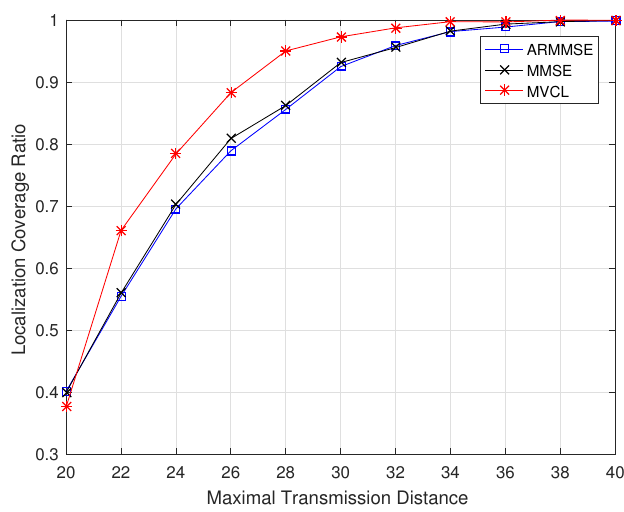
Figure 11. Localization coverage ratio with transmission range R ( n = 80, m = 20, k = 4, ζ = 15, η = 3).